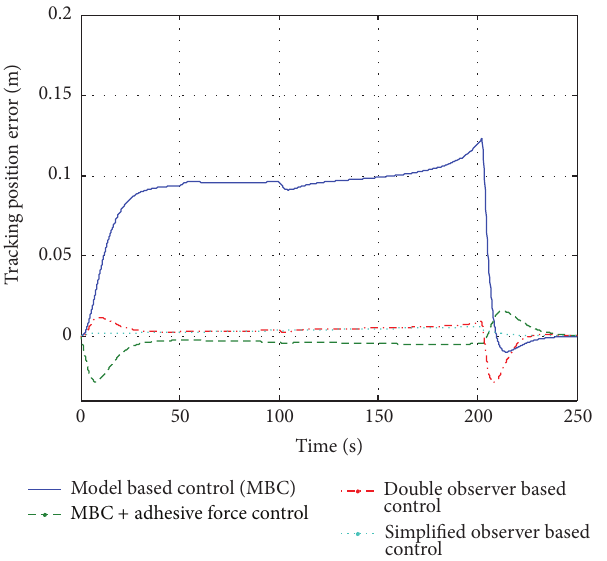
Figure 9: Slip ratio of each driving wheel.